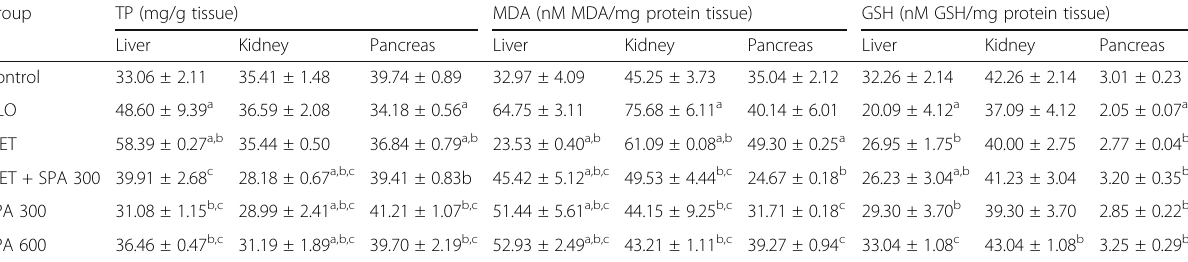
Table 4 Effect of methanol extract of S. sparganophora leaves on total protein, malondialdehyde, and reduced glutathione in alloxan-induced hyperglycemic rats